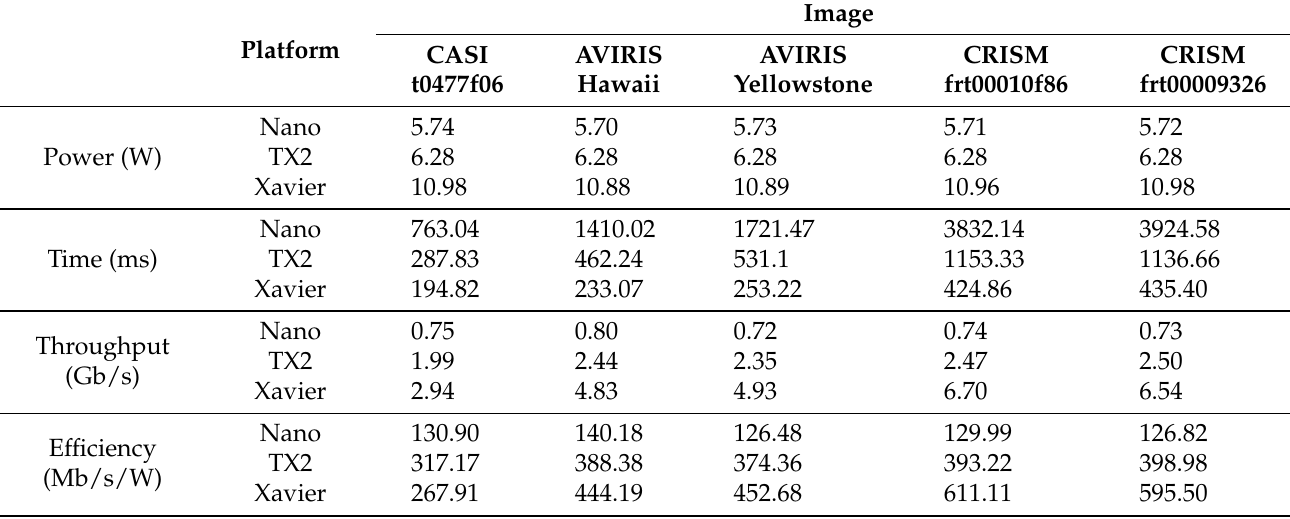
Table 5. Overall performance for the tested images using the parallel predictor and block adaptive entropy encoder in the maximum power